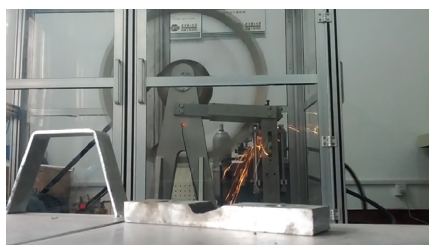
Figure 4: Multiple impact experiment.